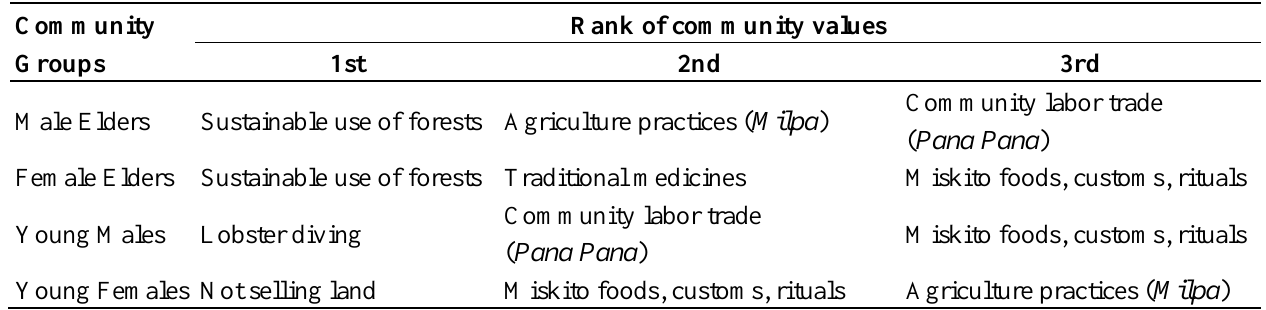
Table 5. Ranking of community values by community